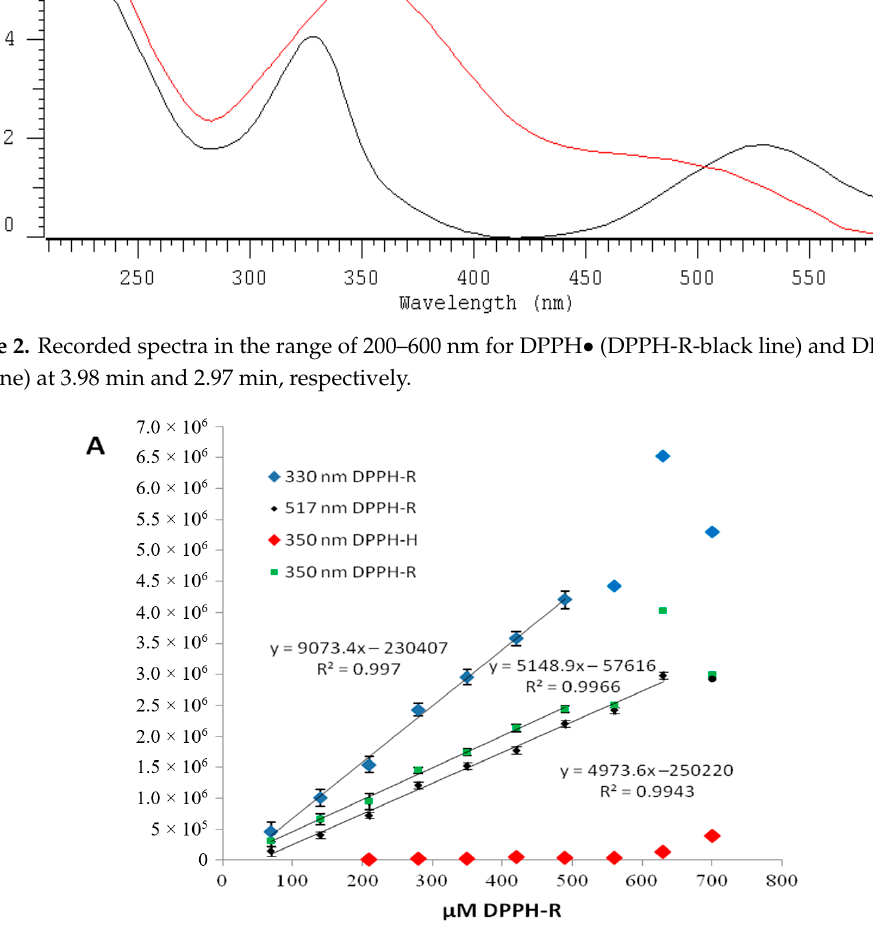
Figure 2. Recorded spectra in the range of 200–600 nm for DPPH• (DPPH-R-black line) and DPPH- H (red line) at 3.98 min and 2.97 min, respectively.